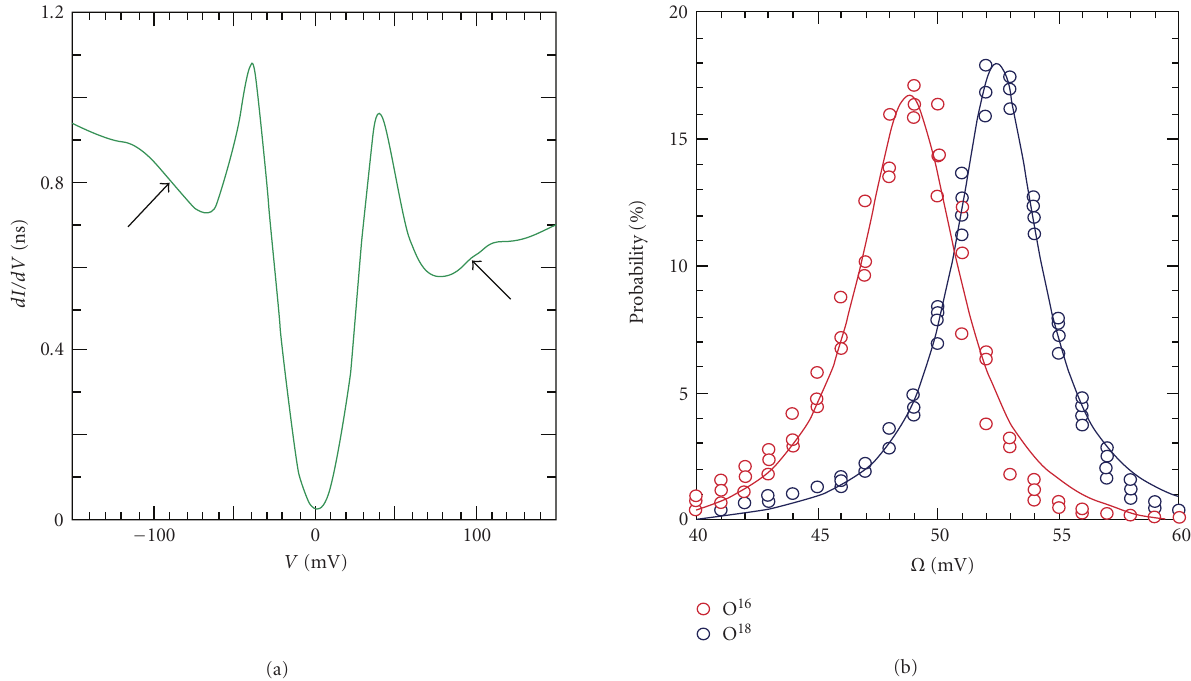
Figure 32: (a) Typical conductance dI/dV ( r , E ). The ubiquitous features at eV > Δ (gap) with maximal slopes, which give peaks in d 2 I/dV 2 ( r , E ), are indicated by arrows. (b) The histograms of all values of Ω ( r ) for samples with O 16 —right curve and with O 18 —left curve. From